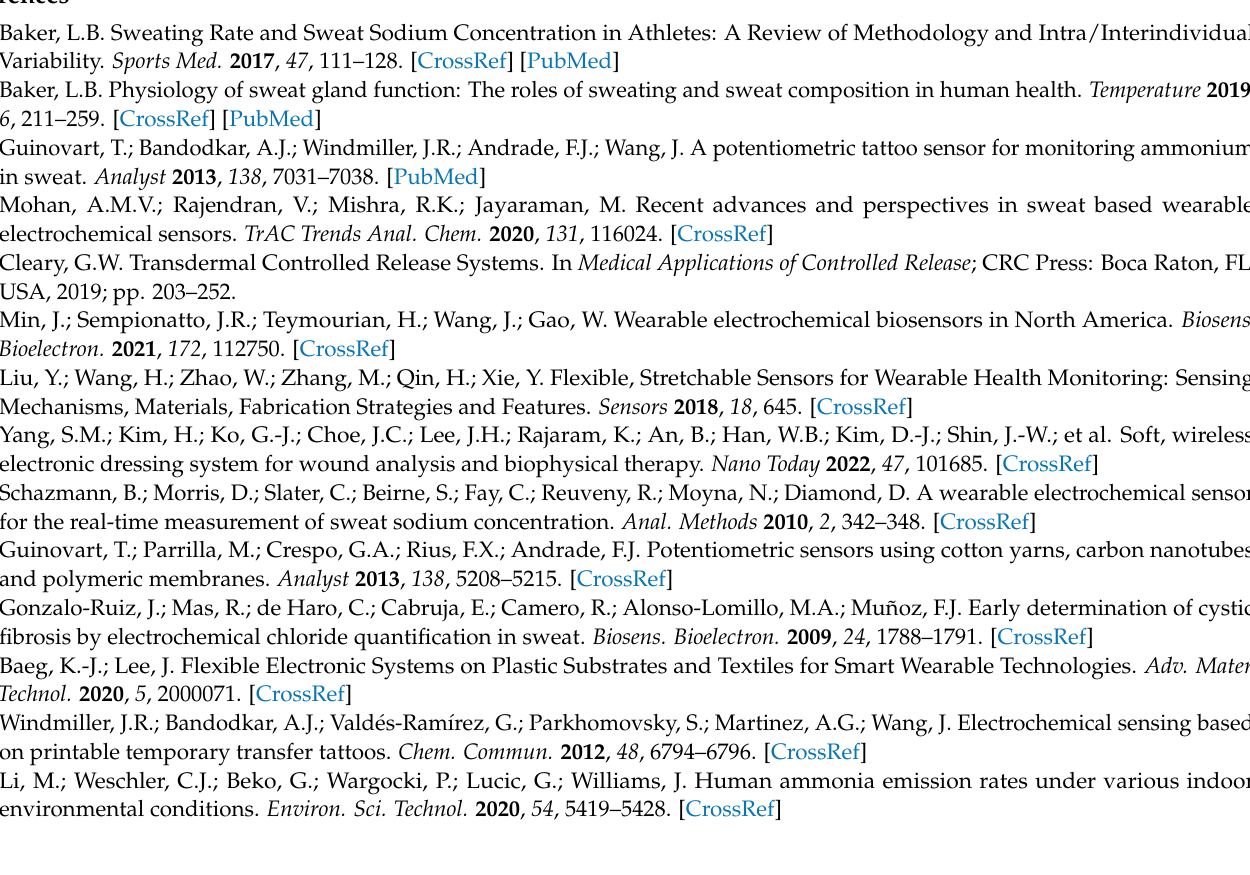
LiClO 4 ; Figure S2: Detailed modification process of the Graphene–CNT layer: (a) Key parameters; (b) Setup; Figure S3: (a) Schematic diagram of the layer structure and interfaces in the sensing process, (b) equivalent circuit model (ECM); Table S1: Key parameters in ECM for EIS measurements; Figure S4: Mechanism of ion selectivity based on the specific molecular structure of the ionophore; Figure S5: Contact angle test results of (a) screen-printed bare carbon and the (b) Graphene–CNT modified